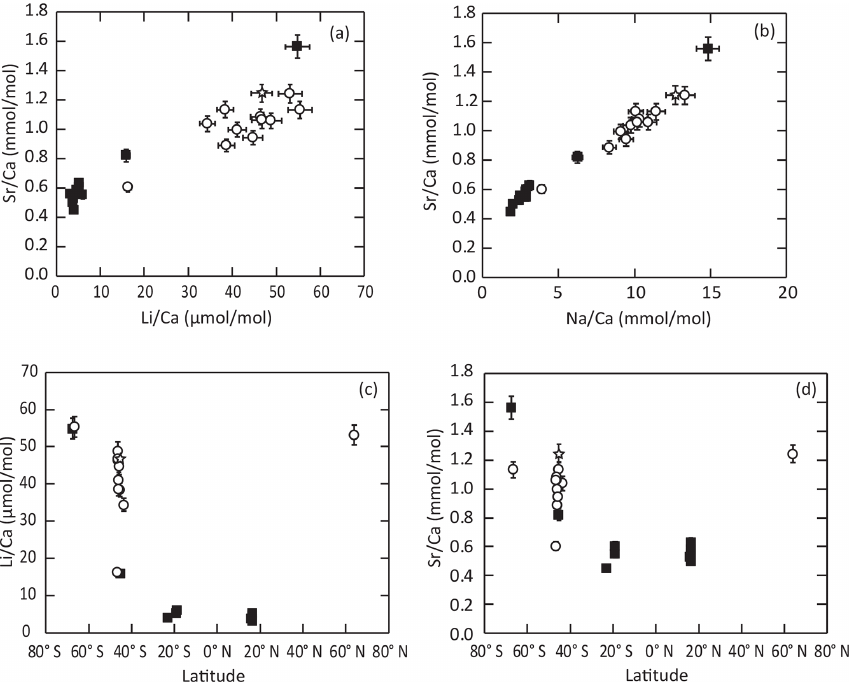
Figure 6. Distribution of trace element content of the inner shell layers among the different brachiopod taxonomic groups (same symbols as in Fig. 5c). The data show a strong correlation between Sr / Ca and Li / Ca (a) and Sr / Ca and Na / Ca (b) , as well as strong latitudinal partitioning of Li / Ca (c) and Sr / Ca (d) values.